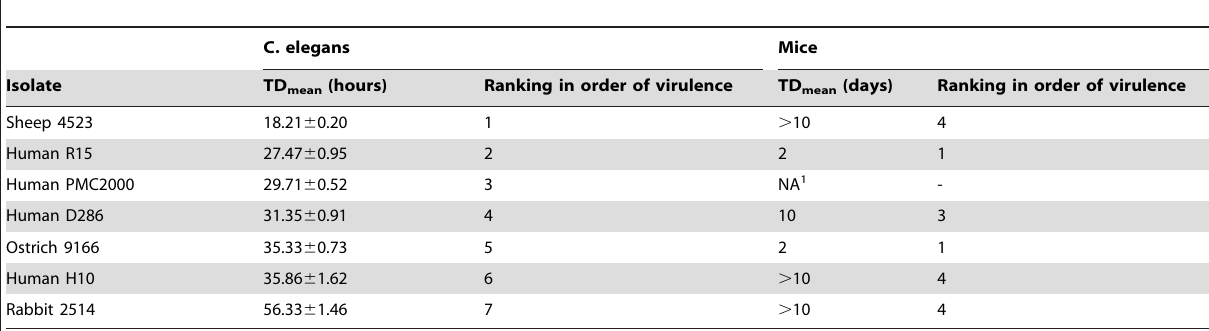
Table 2. Calculated TD mean for B. pseudomallei isolates in infected C. elegans and